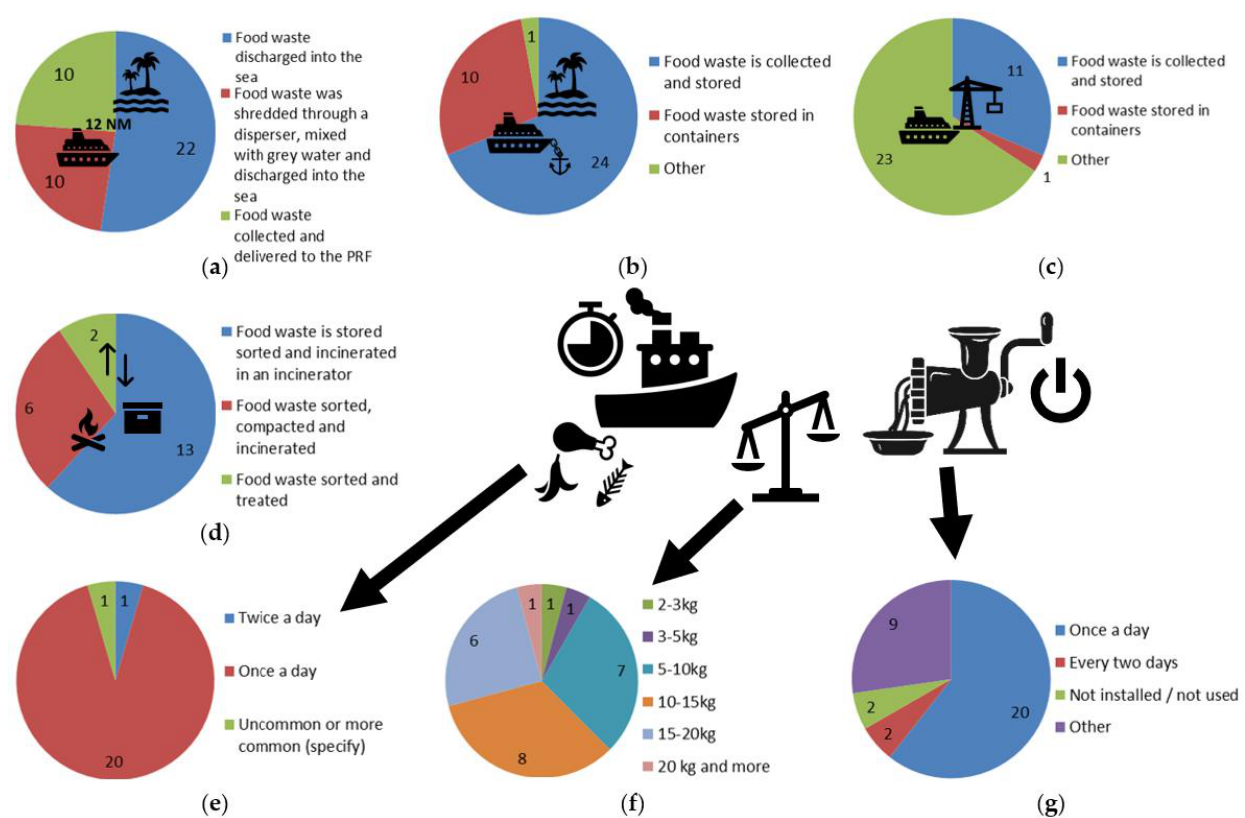
Figure 4. The numerical distributions of answers from respondents about the specific location for food waste treatment: ( a ) in open waters of the Baltic Sea area (further than 12 NM from the shore); ( b ) closer than 12 NM to the nearest land; ( c ) while anchored in a port; and ( d ) added explanation: “other”. The respondents also provided statistical information about ( e ) the frequency and ( f ) the amount of shredded or ground food waste disposed at sea and about ( g ) the operating frequency of the food waste shredder. The attached icons indicate described situations and processes.